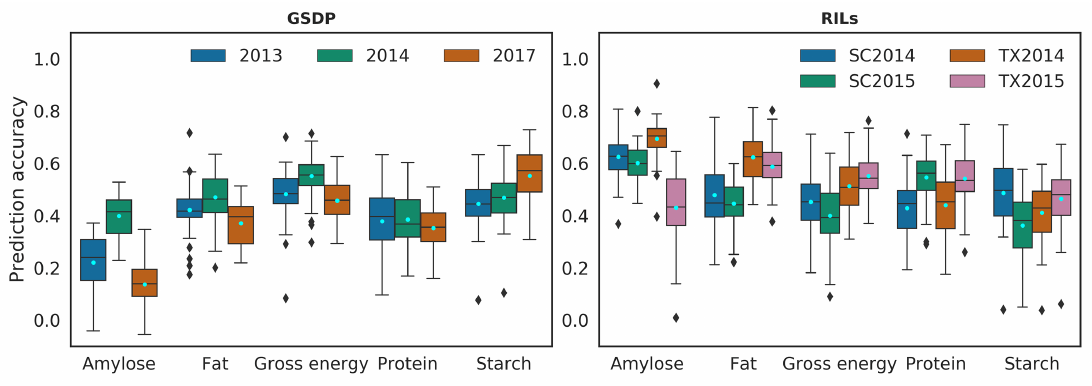
Figure 2. Prediction accuracy for single-trait single-environment (STSE) model. The y-axis shows prediction accuracy calculated as Pearson’s correlation between observed values and predicted values of phenotypes. Legend represents the environment/years. SC: South Carolina, TX: Texas, GSDP: Grain sorghum diversity panel, RILs: recombinant inbred lines. Pale blue dots represent the mean of prediction